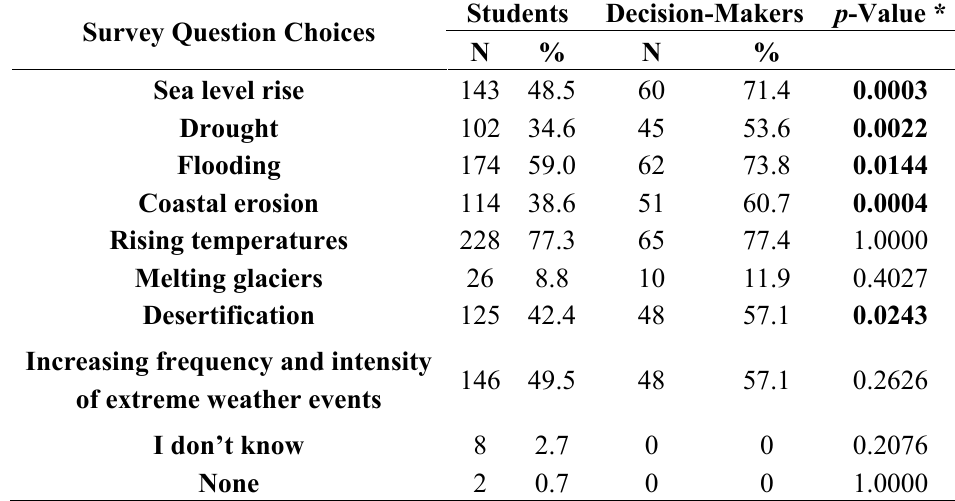
Table 6. Response to “which of the following will affect Nigeria as a consequence of climate